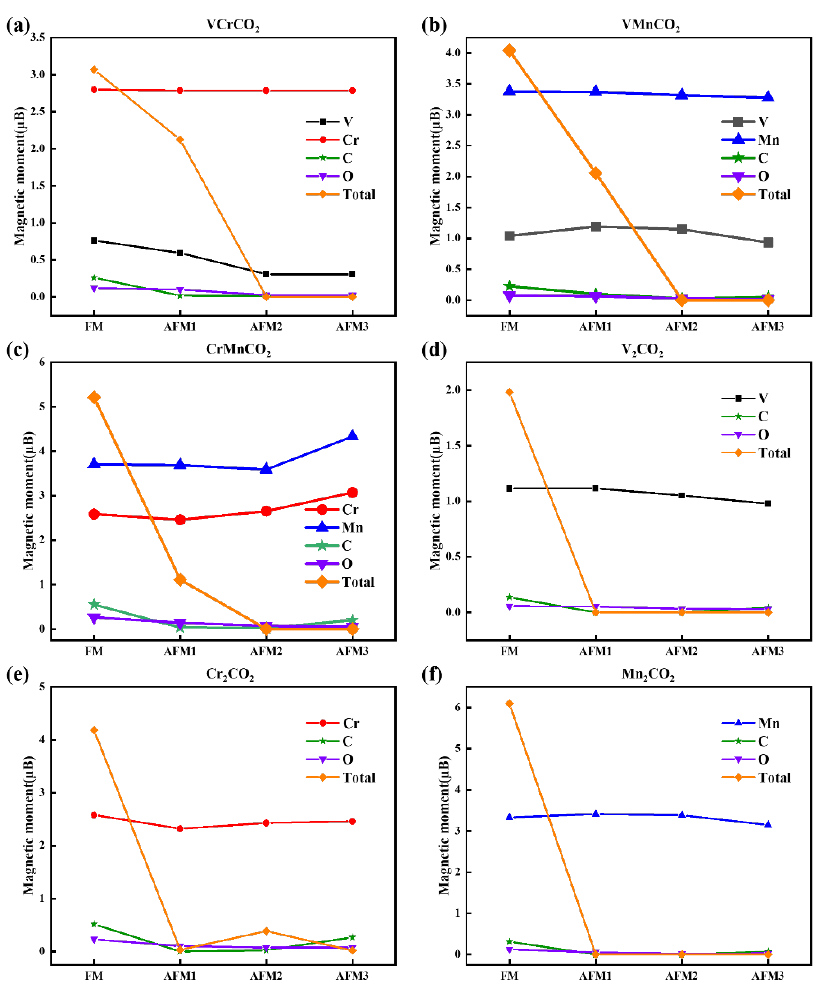
Figure 4. Magnetic moment curves under different M’MCO 2 configurations. ( a ) VCrCO 2 configura- tion; ( b ) VMnCO 2 configuration; ( c ) CrMnCO 2 configuration; ( d ) V 2 CO 2 configuration; ( e ) Cr 2 CO 2 configuration; ( f ) Mn 2 CO 2 configuration.